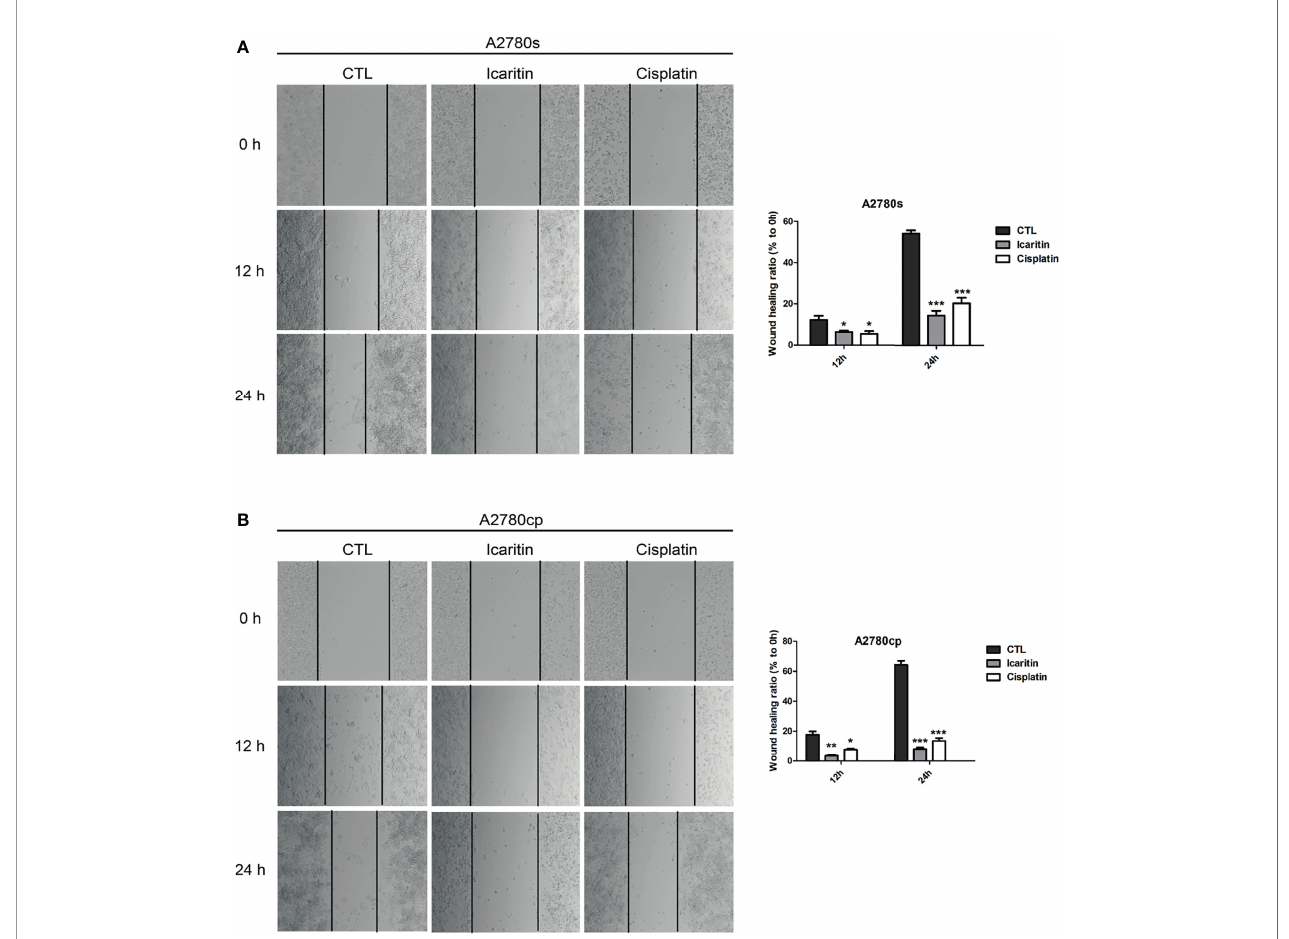
FIGURE 2 | The effects of icaritin or cisplatin on the horizontal motility of A2780s and A2780cp cells by wound-healing scratch assay. (A) A2780s were treated with icaritin (20 m M) or cisplatin (1.6 m g/ml) for 12 h or 24 h, respectively. Representative images and quanti fi cation of the migrated cells are shown. Data are represented as means ± SEM. *** p < 0.001 by 2-tailed Student ’ s t -test. (B) A2780cp cells were treated with icaritin (20 m M) or cisplatin (1.6 m g/ml) for 12 h or 24 h, respectively. Representative images and quanti fi cation of the migrated cells are shown. Data are represented as means ± SEM. * p < 0.05, *** p < 0.001 compared to CTL group by 1-way ANOVA followed by Tukey ’ s post-hoc test. **p <